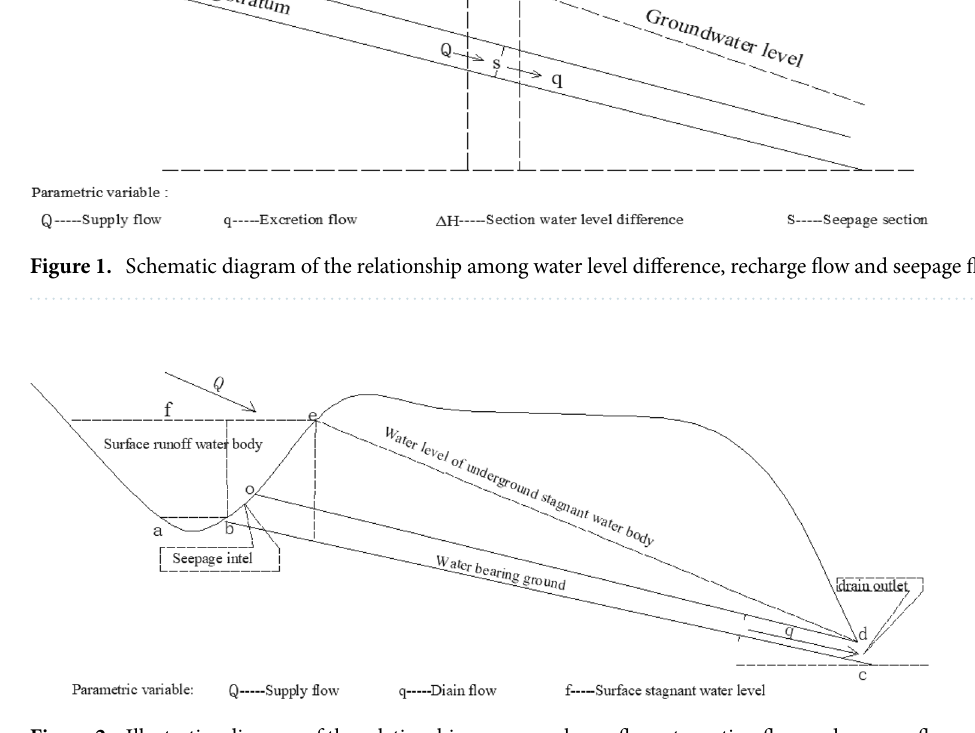
Figure 2. Illustrative diagram of the relationship among recharge flow, stagnation flow and seepage